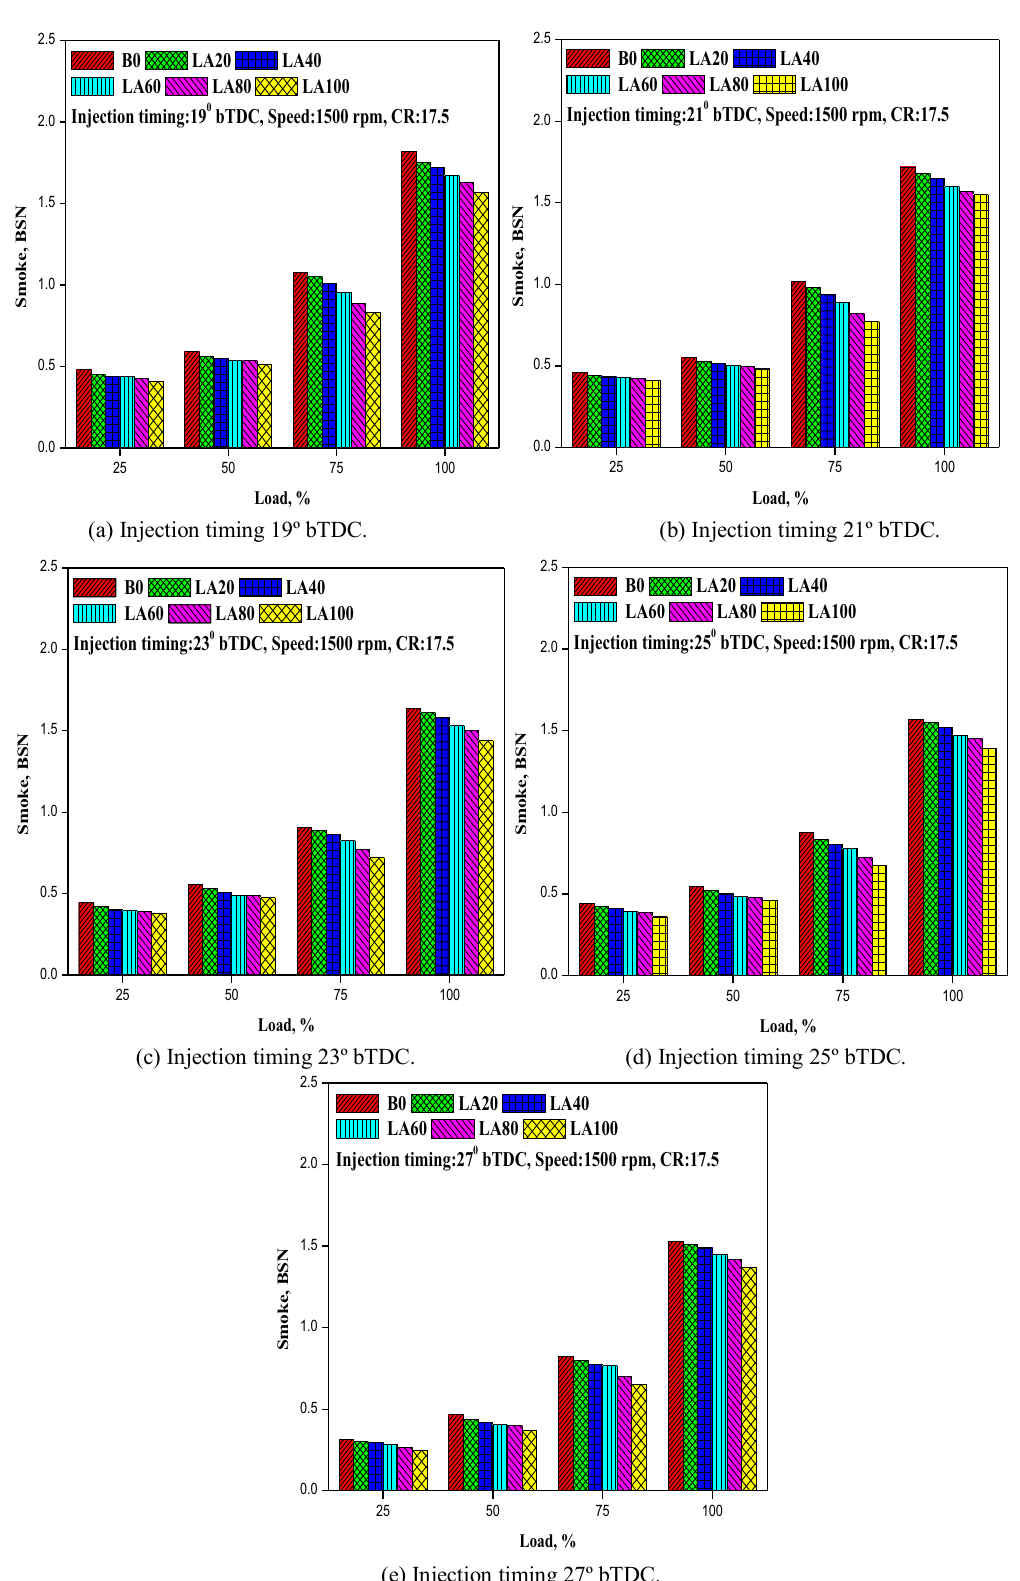
Figure 11. ( a–e ) The variation in smoke emision with different FITs and engine load for considered fuel